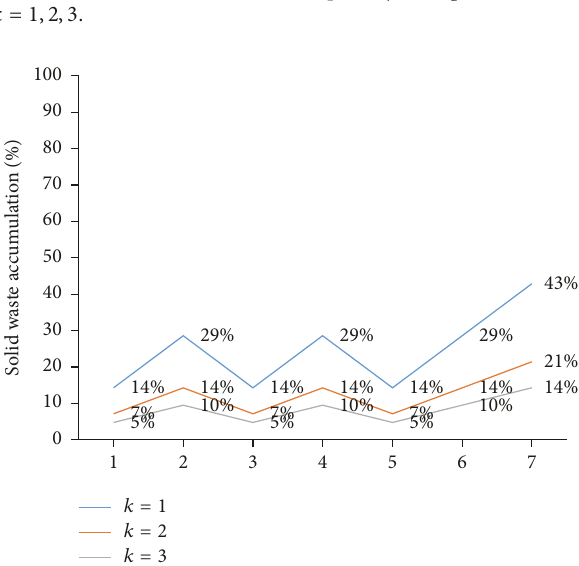
Figure 4: Solid waste accumulation per day 𝑡 for 𝑝 = 10, 11 and 𝑘 = 1, 2,3